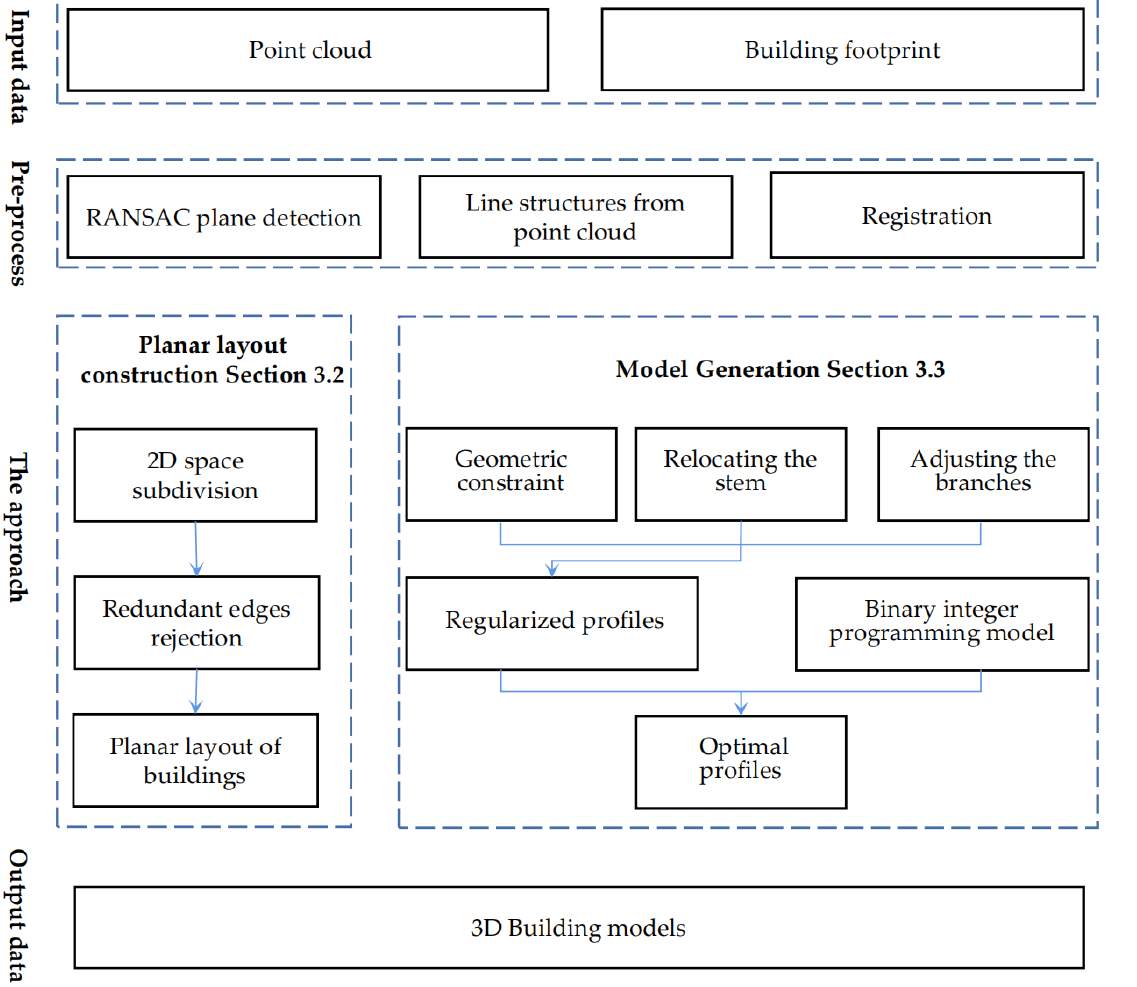
Figure 1. Workflow of the proposed building reconstruction method.